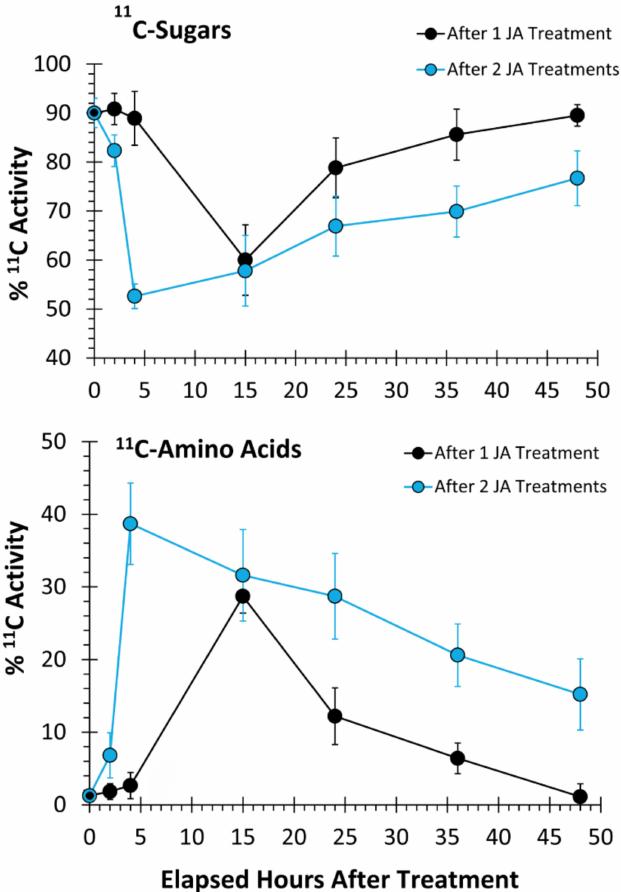
Figure 3. Local tissue responses to 500 µ M JA treatments—metabolic partitioning of ‘new’ carbon resources (as 11 C) into soluble sugar and amino acid pools. Data are presented as relative % 11 C activity from load leaf solvent extraction and reflect N = 3 5 biological replicates ±